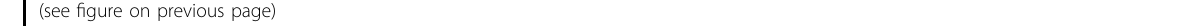
Fig. 3 CAF subtype-speci fi c TFs and the interactions between different CAFs and MDSCs. a Dotplot shows transcriptional factors enriched in different human CAF subclusters. b , c UMAP plots show top expressed TFs from CAF clusters. d Violin plots show targeted genes from TFs in human CAF clusters. e Heatmap show TFs enriched in different murine CAF subclusters. f Violin plots show targeted genes from TFs in murine CAF clusters. g The activity of adipogenesis pathway gene signatures in different human CAF subclusters. h , i The mIF show CD36 + CAFs signi fi cantly enriched in human HCC than adjacent liver tissues. j The correlation between CD36 + CAFs and MDSCs, effector CD8 + T cells from scRNA-seq data. k The correlation between CD36 + CAFs and MDSCs in HBV-related HCC cohort. l The correlation between CD36 + CAFs and effector CD8 + T cells in HBV- related HCC cohort. m The correlation between CD36 + CAFs and MDSCs from snRNA-seq data. n MIF staining showed CD36 + CAFs interacted with MDSCs in closer proximity. Data shown as mean ± S.E.M., one-way ANOVA following multiple comparison test was used, *** P < 0.001, ** P < 0.01, * P < 0.05, and ns not signi fi